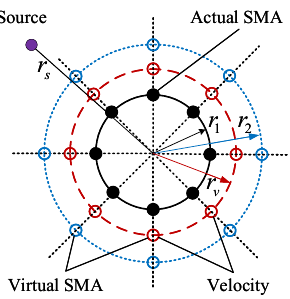
Figure 2. Difference schematic diagram of dual-radius spherical array. The black circle and dot represent the actual SMA and the array element respectively, and the red and blue represent the virtual SMA. In addition, the red circle also indicates the position of the velocity obtained by the